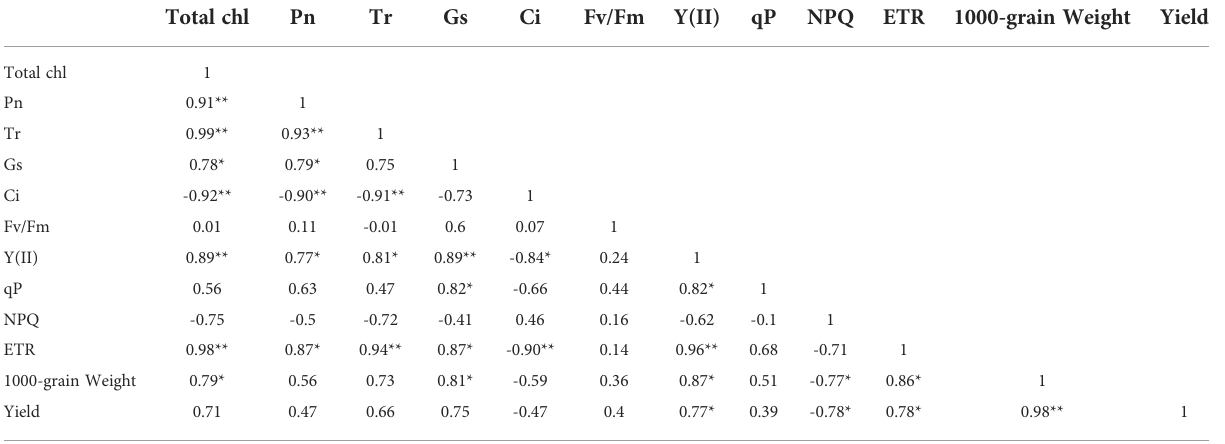
TABLE 5 Correlation between photosynthetic characteristics and yield in foxtail